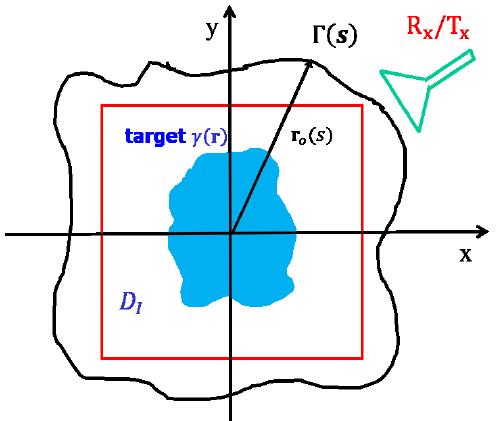
Figure 1. Geometry of the